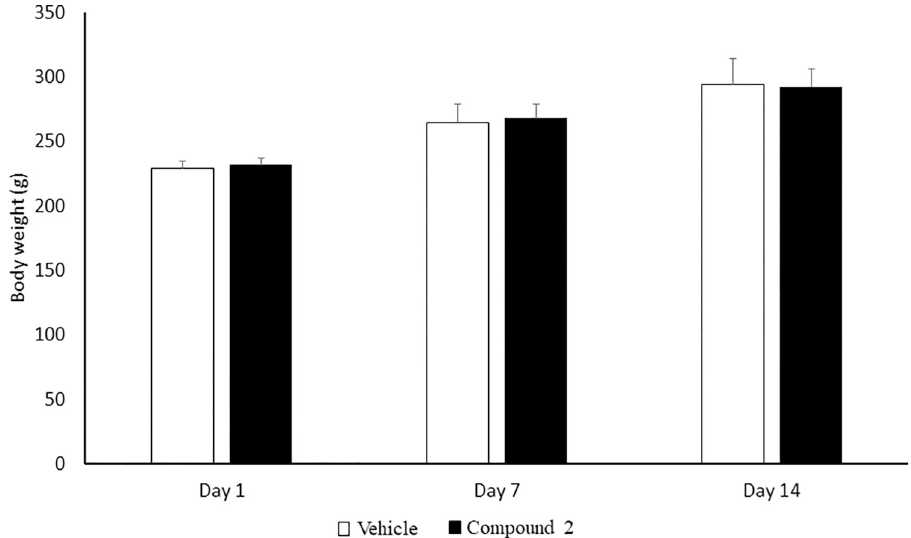
Fig 2. Mean body weight of vehicle and compound 2-treated rats. Body weight was measured at three intervals of the study period. Data are expressed as a mean ± standard error of mean (S.E.M) (n = 3).